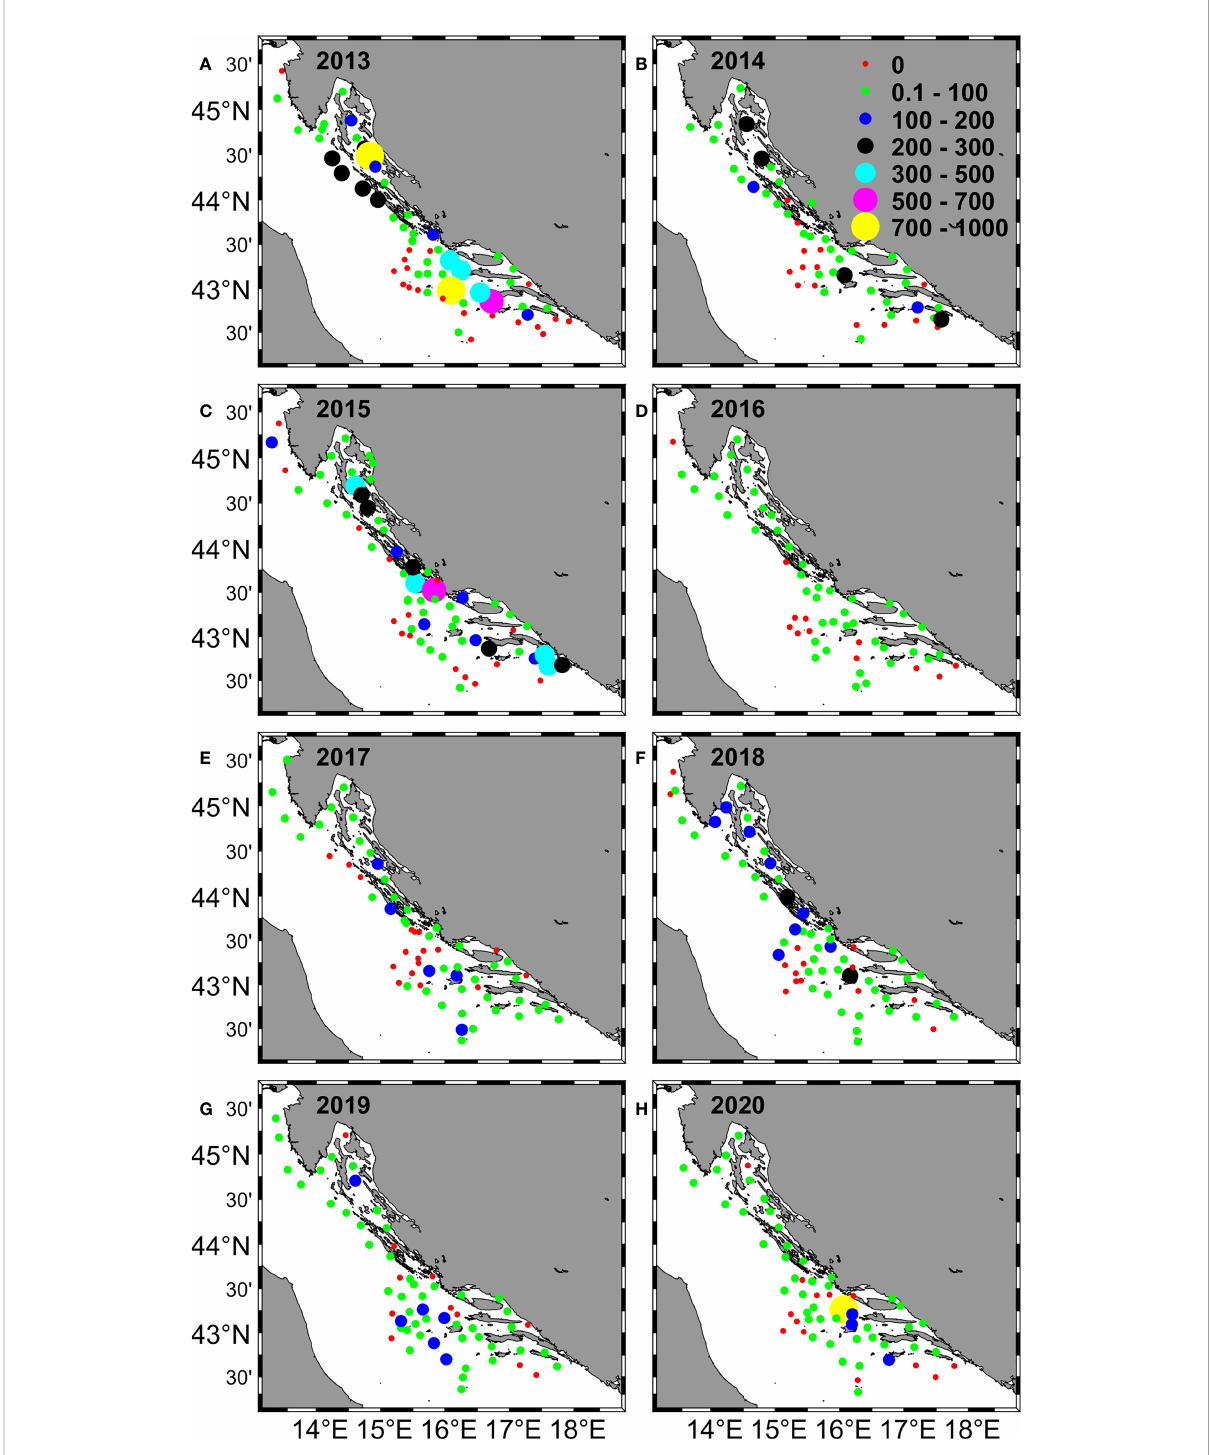
FIGURE 2 Distribution of Adriatic anchovy eggs collected in the eastern Adriatic Sea during summer surveys from 2013 to 2020 (A – H) . The abundance of eggs (eggs/m 2 ) is represented by different circle sizes and